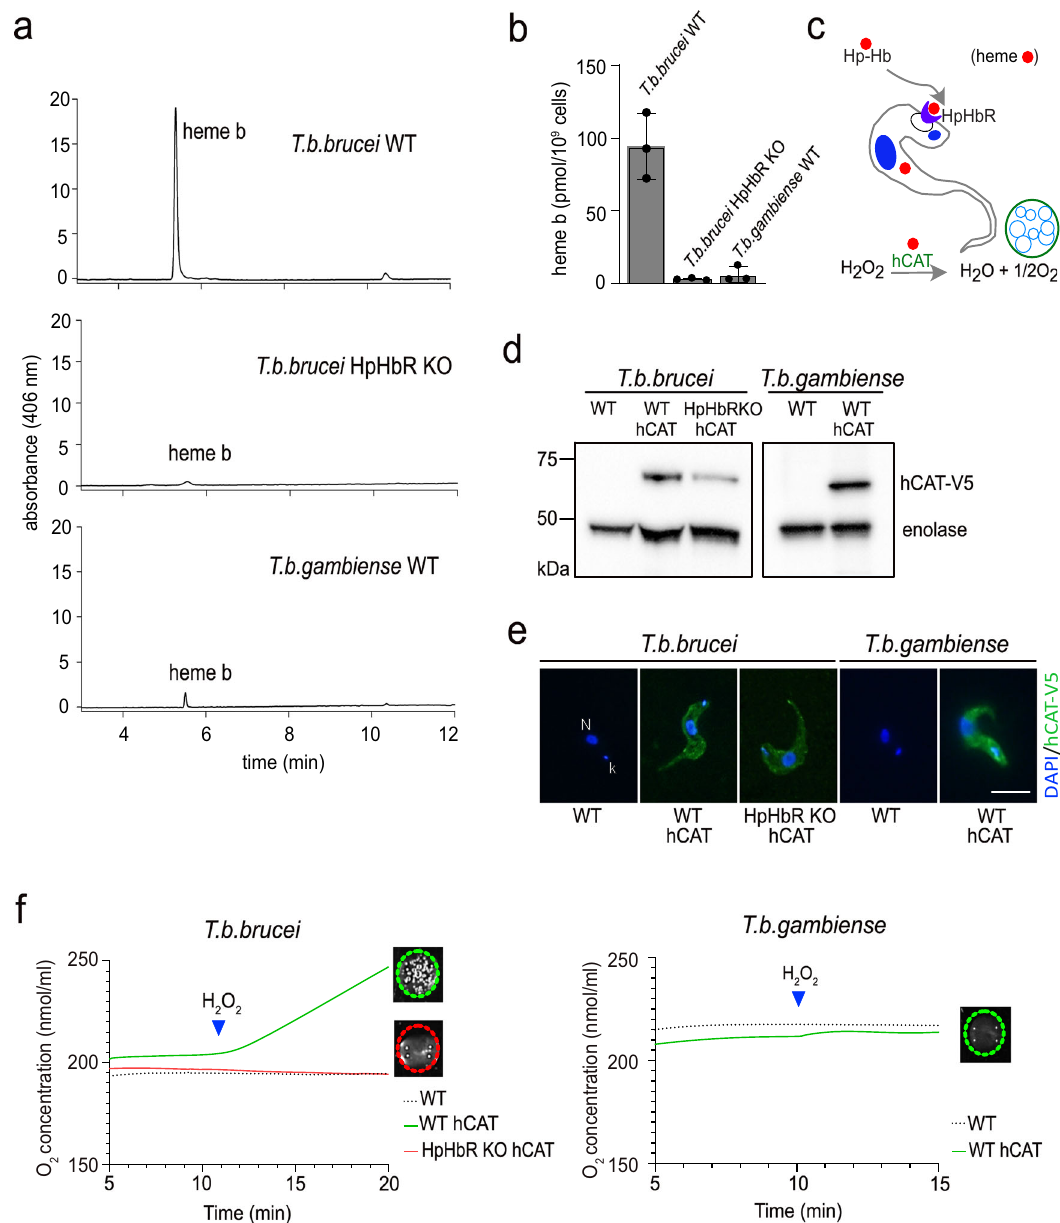
Fig. 1 | Detection of heme and hemoproteins in bloodstream stages of T. b. brucei and T.b.gambiense .a Heme b extractedfrom1×10 9 cellswasseparatedby HPLCand detected by a diodearray detector. Representative chromatogramfrom wild type T. b. brucei , T. b. brucei knock-out for HpHbR and wild type T. b. gam- biense . b Graphshowingquanti fi cationoftotalheme b contentinthesamecelllines as in ( a ); ( n =3). c Schematic representation of the experimental design used to measure the activity of the N-terminally V5-tagged human catalase (hCAT) in the bloodstream T. brucei . d Western blot analysis with V5 antibody detecting human catalase (hCAT) in WT and HpHbR knock-out (KO) of T. b. brucei and WT T. b.